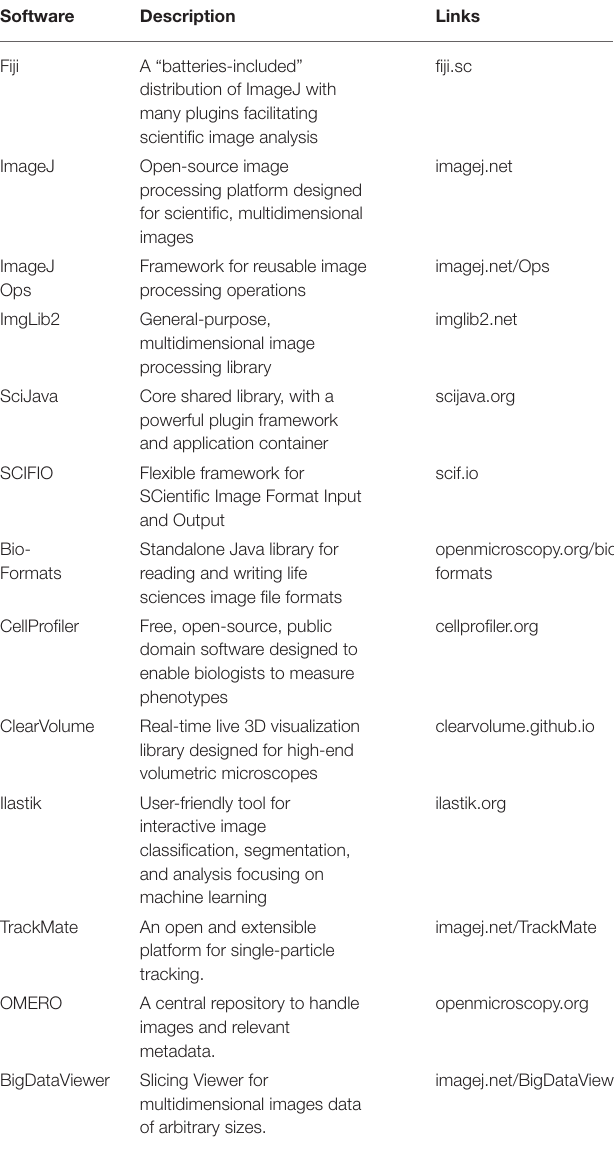
TABLE 1 | Representative integrated tools and libraries related to bioimage data